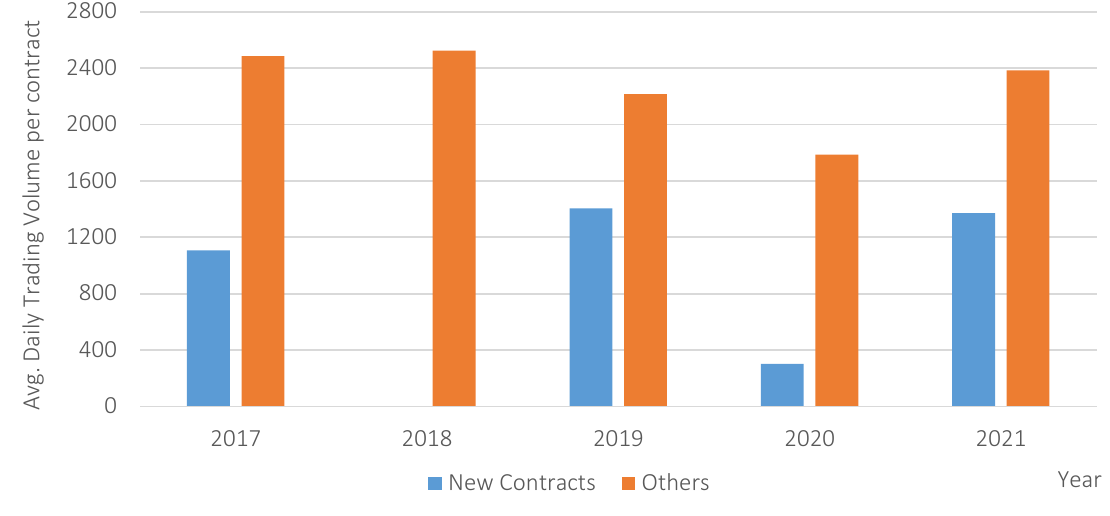
Figure 1. Average daily trading volume comparison between new contracts and others